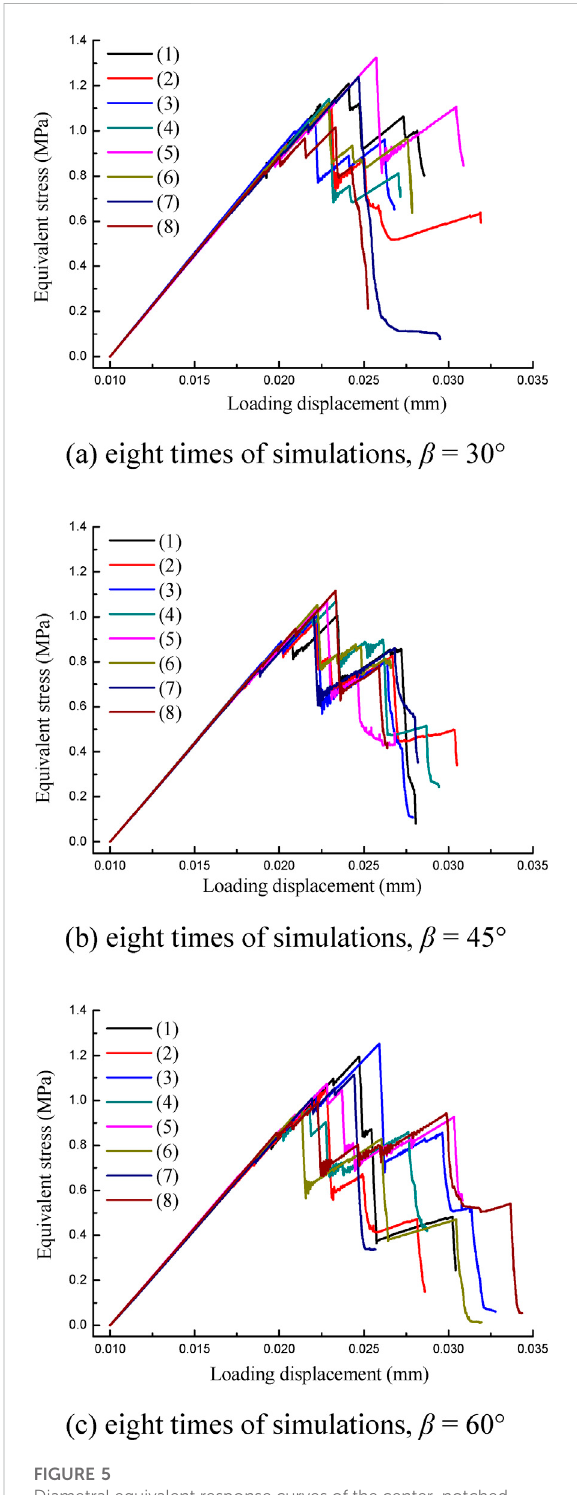
FIGURE 5 Diametral equivalent response curves of the center-notched disc specimen with different β under the same heterogeneity degree ( m =